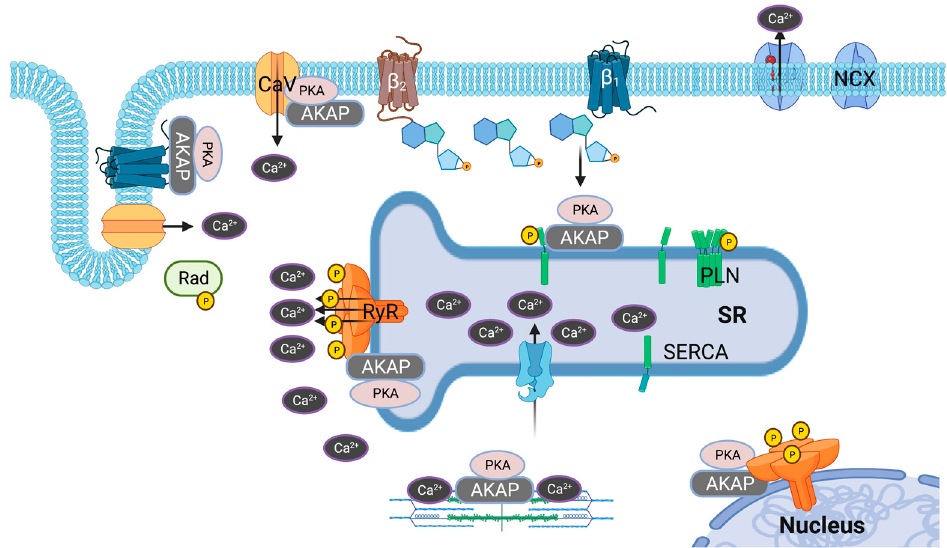
Figure 2. Dysregulation of calcium cycling in heart failure: During heart failure, calcium cycling is affected due to the loss of T-tubules and reduced expression/activity of SERCA2a. RyR2 is hyperphosphorylated leading to increased calcium sparks. Illustrations in Figure 2 are created with